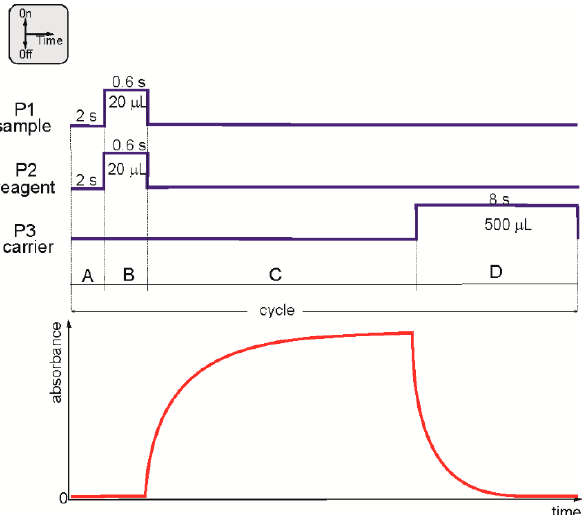
Figure 5. Example of the micro-pumps program (blue line) with absorbance signal (red line) measured during one cycle. A, zeroing the absorbance signal; B, injection of the sample and the reagent; C, formation of a colored reaction product; and D, cleaning of the reaction chamber.